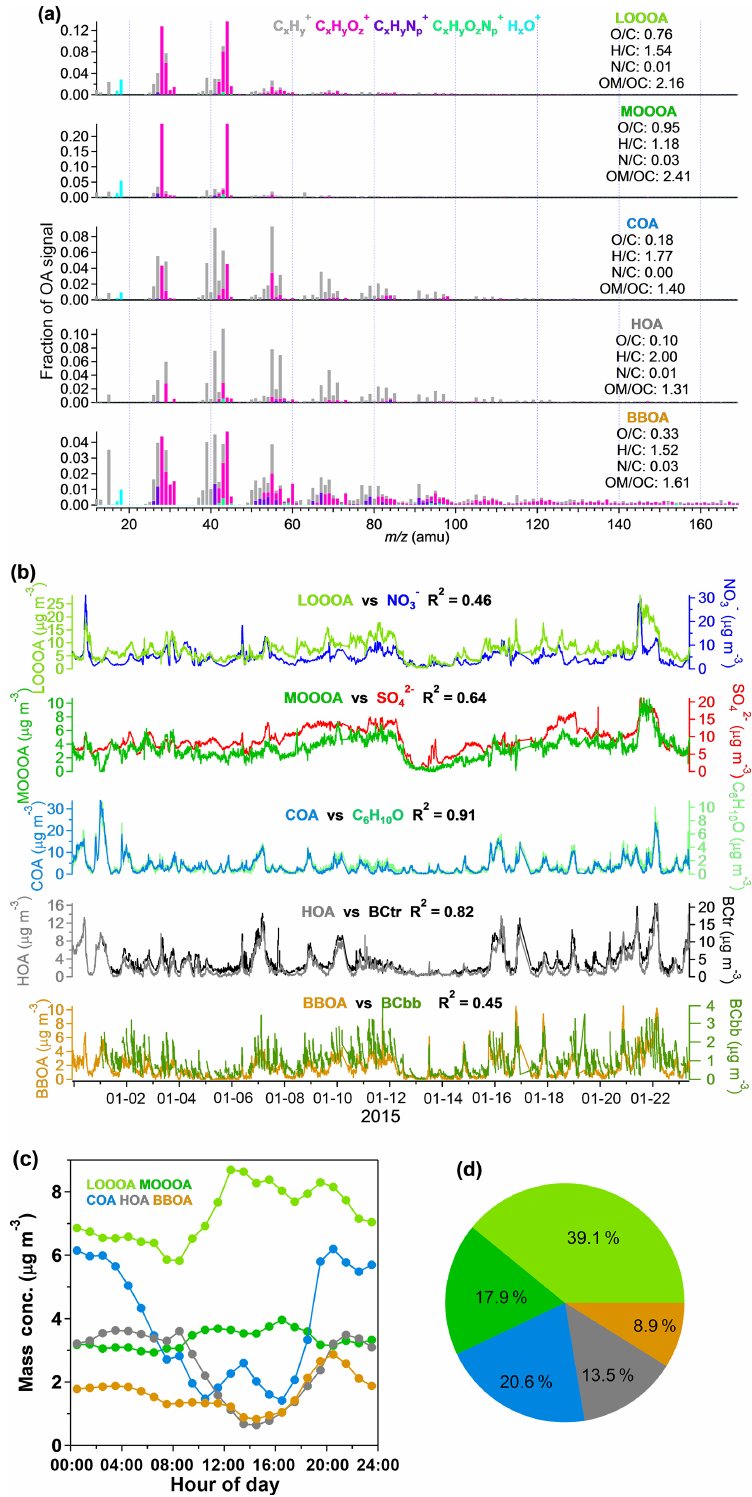
Figure 3. (a) MS profiles of the five OA factors identified by PMF; (b) time series of the five OA factors and the correlation with the relevant species during the experiment; (c) the diurnal variation in the five OA factors; (d) the average contributions of the five OA factors to total OA. The time series, diurnal variation, and pie chart display the results only for ambient conditions.